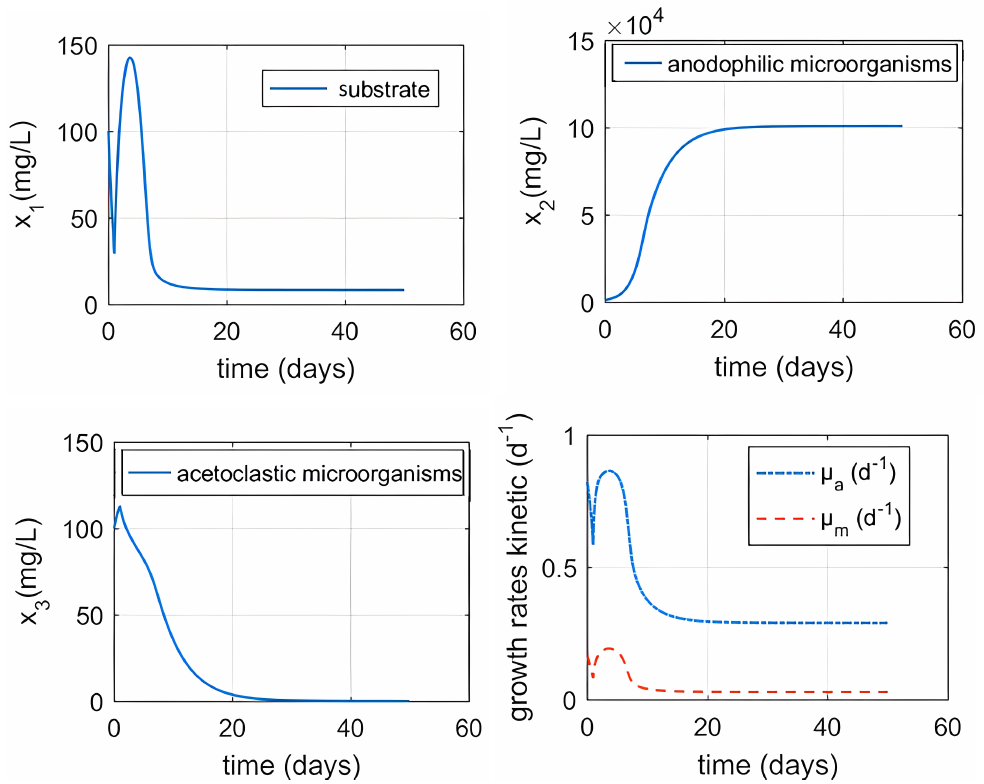
Figure 3. Plots of the dynamic behavior of state variables and microorganisms’ growth